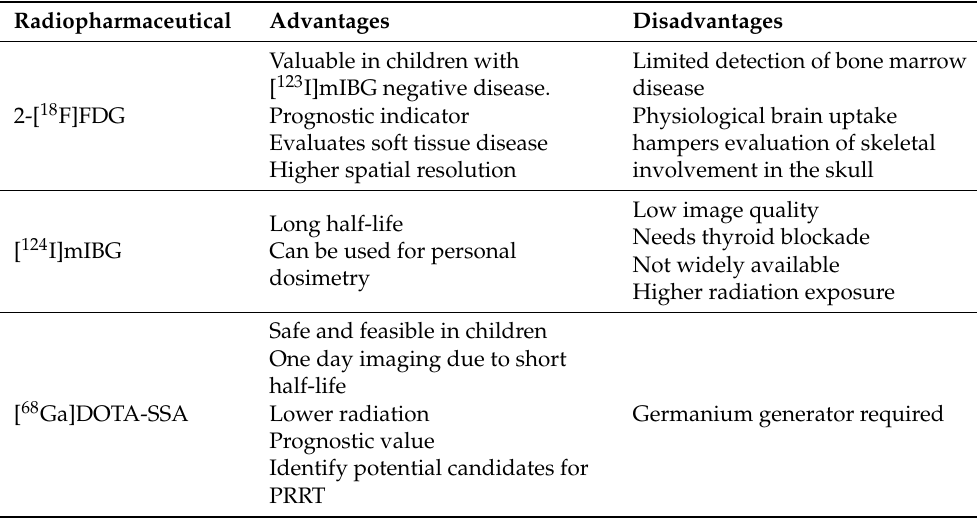
Table 1. Summary of PET tracers used for imaging